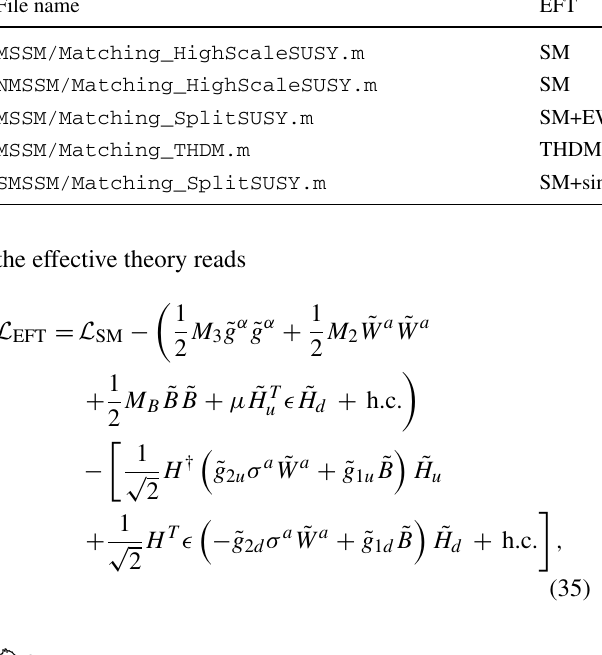
Table 2 Input files for the analytical approach which are now delivered with SARAH . The hierarchy in the last column refers to Fig. 7. For the split-NMSSM also a light singlet is present, i.e. the hierarchy is similar to ( c ) , but not identical